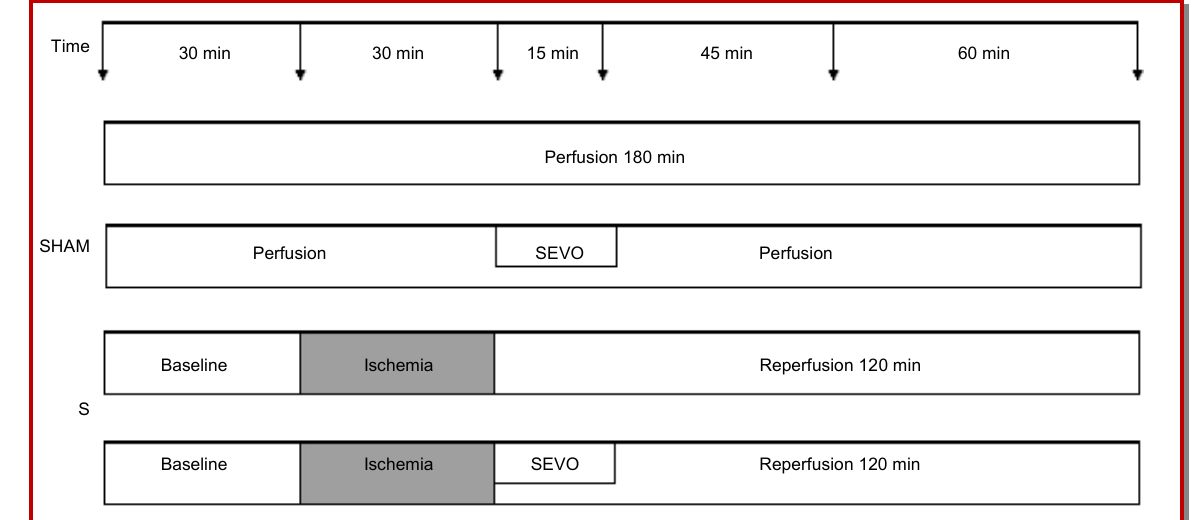
Figure 1: Experimental design of perfusion in different